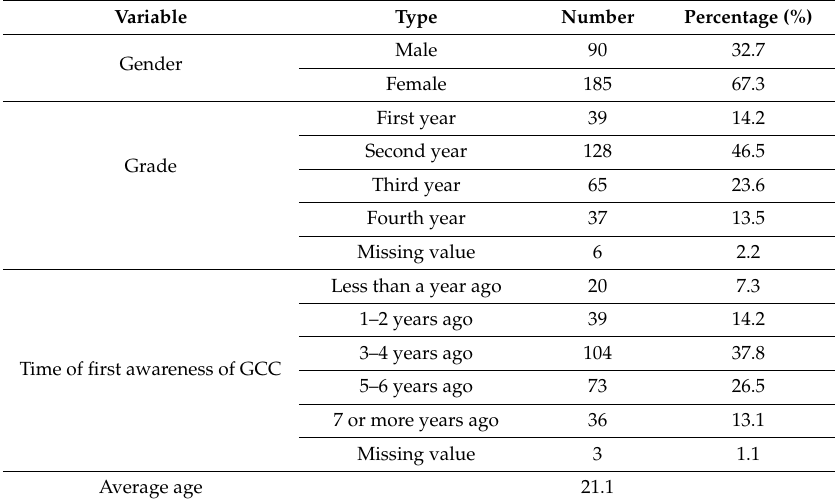
Table 1. Statistics of research